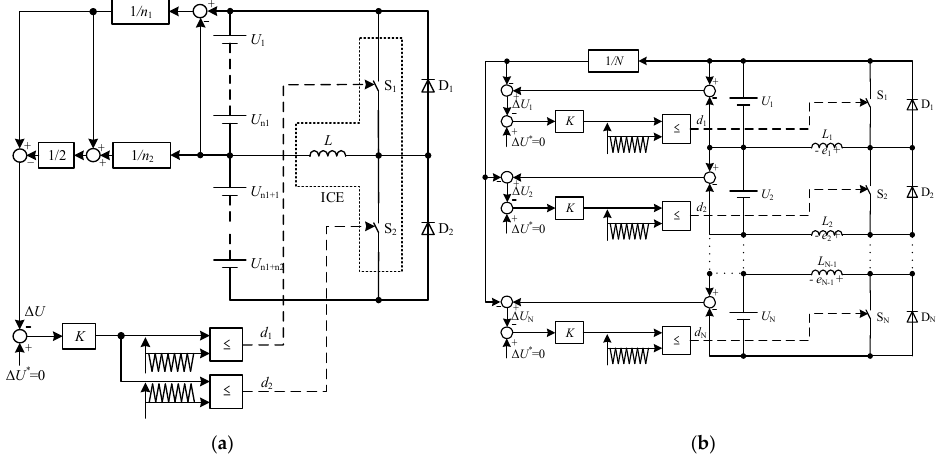
Figure 7. Application of the control strategy. ( a ) The application in the cell ‐ to ‐ cell topologies; and ( b ) the application in the cell ‐ to ‐ pack topologies. Table 2. Corresponding relations between d and S .